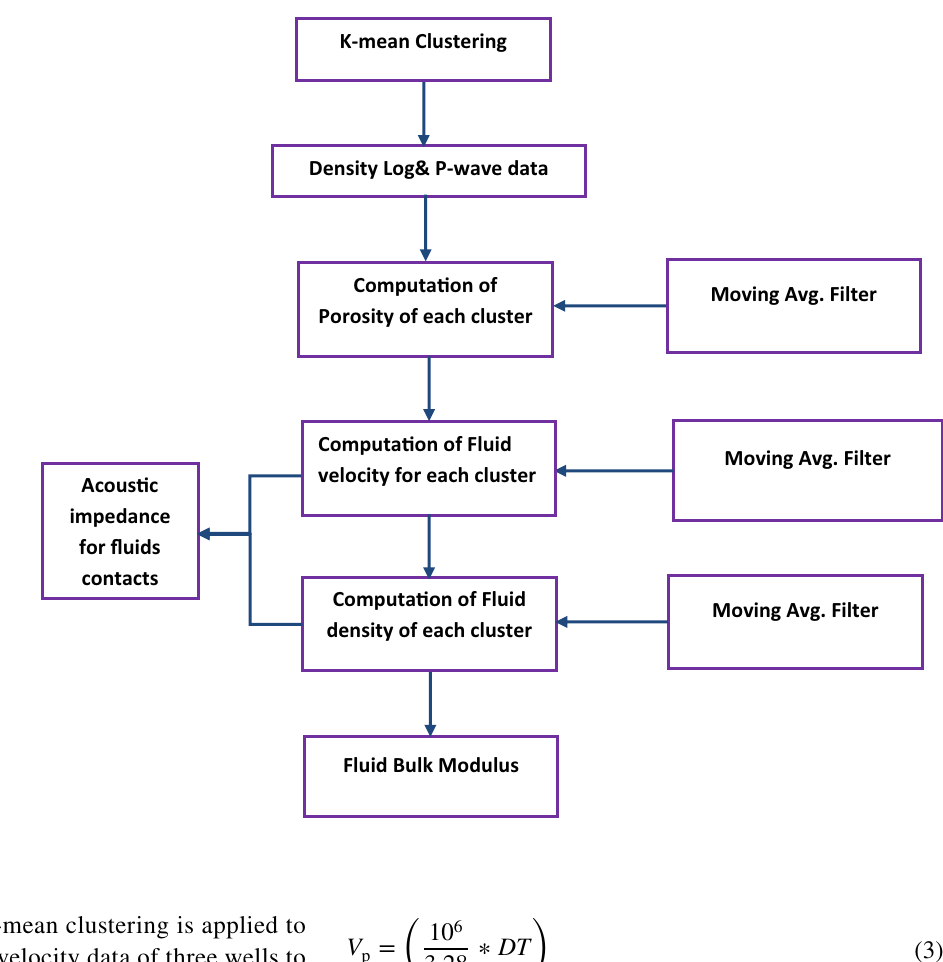
Fig. 1 Workflow chart of the proposed